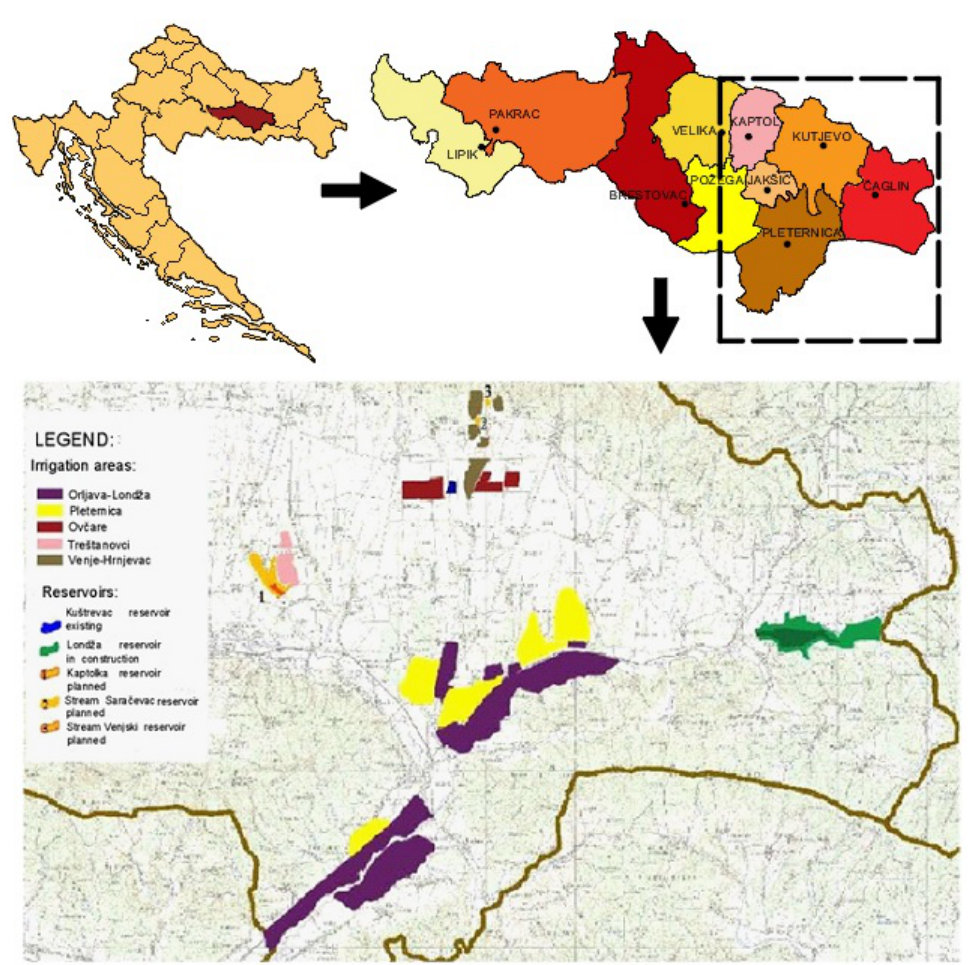
Figure 1. Study area: Požega–Slavonia County [23,33].